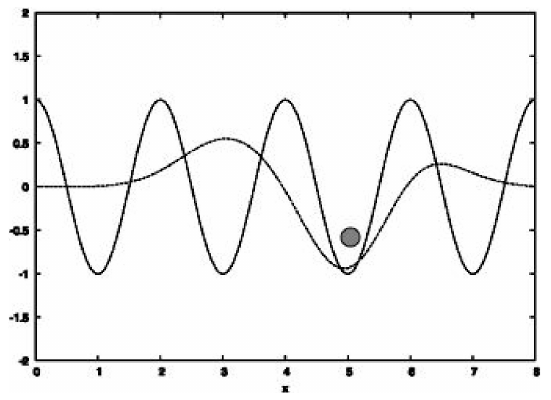
Fig. 10. The Brownian motor proposed in Sect. 4. The particle moves in a periodic potential and noise is acting on it. A perturbing potential 8(x − vt) localized in space is traveling in the system.